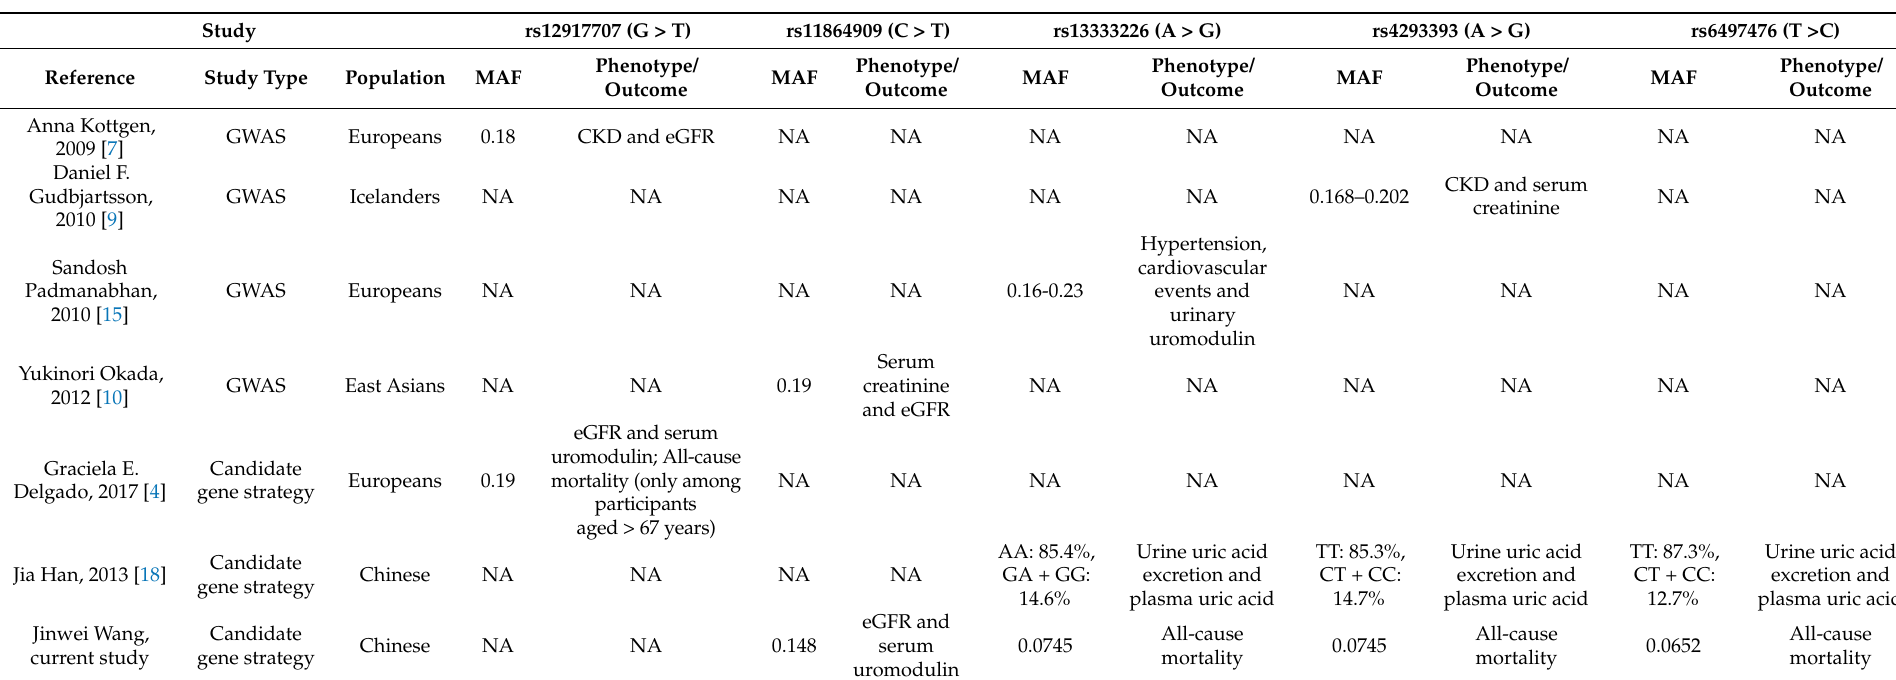
Table 5. Single nucleotide polymorphisms in the promoter region of UMOD gene and their association with clinical phenotype and/or outcome of statistical significance in different studies.